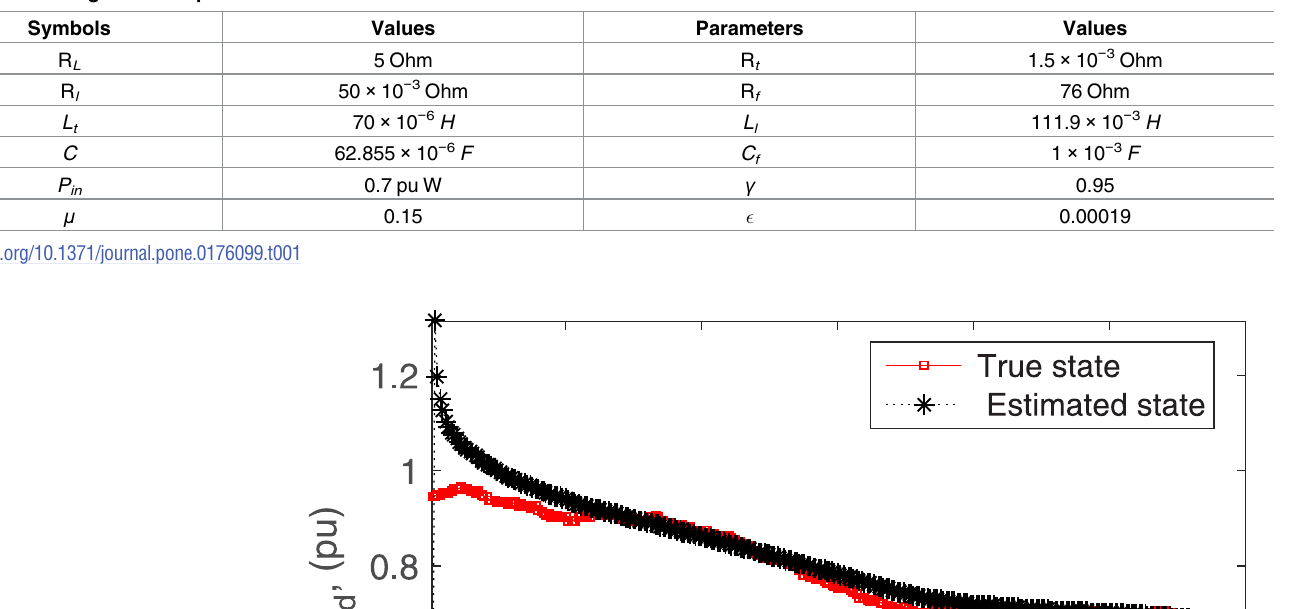
Table 1. AC microgrid and its parameters.